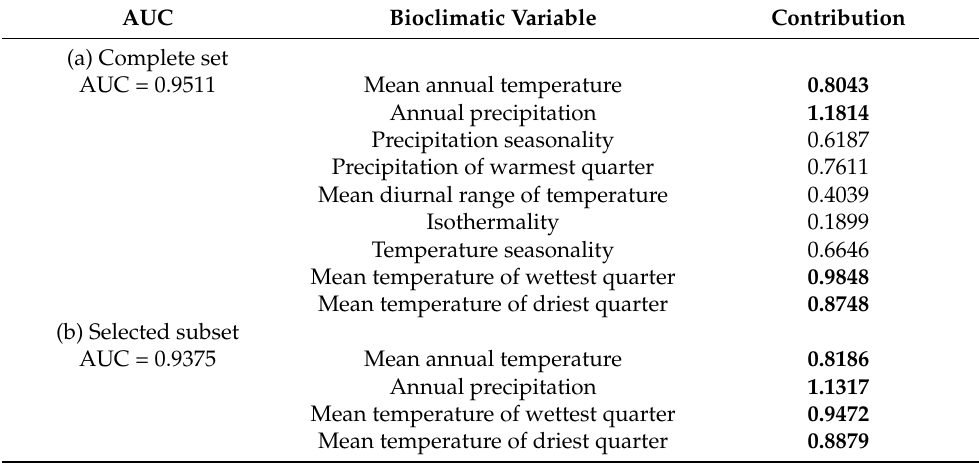
Table 2. Importance levels of bioclimatic variables calculated as contributions in isolation retrieved from MaxEnt models fitted on the occurrence records of the Great Bustard within the Carpathian Basin, computed for (a) the preselected set of nine bioclimatic variables and (b) the selected subset of the four bioclimatic proxies. Variables with high contribution metrics are indicated in bold.